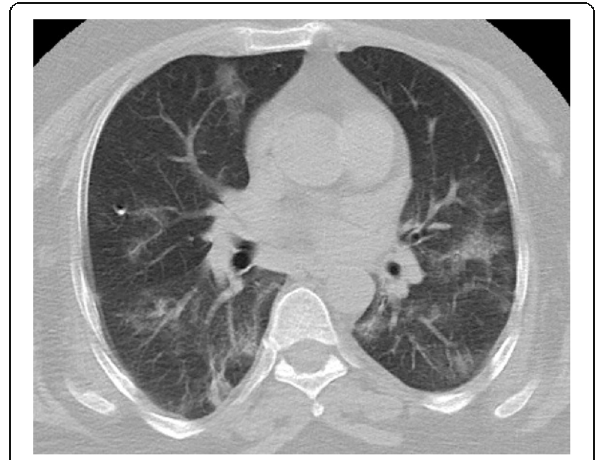
Fig. 1 Bilateral patchy consolidation and ground glass opacities more pronounced in the lower lobes and peripheral-CO-RADS 5. Total Severity Index: 6, 40% involvement